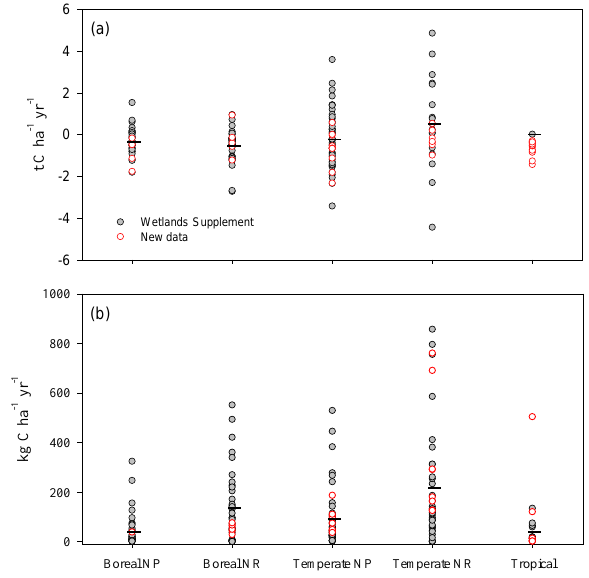
Figure 5. (a) Carbon dioxide (CO 2; t C ha -1 yr -1 ) and (b) methane (CH 4; kg C ha -1 yr -1 ) fluxes disaggregated by climate zone and nutrient status (NP = nutrient poor, NR = nutrient rich). Negative values indicate annual removals and positive values indicate annual emissions. Wetlands Supplement data are shown as grey circles and new data as red circles. Black horizontal line indicates the mean value (derived emission factor) calculated for the Wetlands Supplement